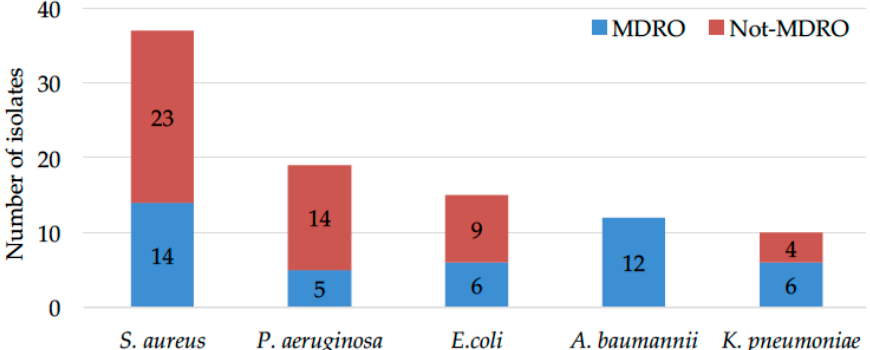
Figure 2. Quantity of not-MDRO (red) compared to its respective counterparts MDRO (blue): MRSA versus MSSA, MDRPA versus P. aeruginosa , ESBL-producing E. coli and K. pneumoniae versus E. coli and K. pneumoniae , respectively, and A. baumannii .